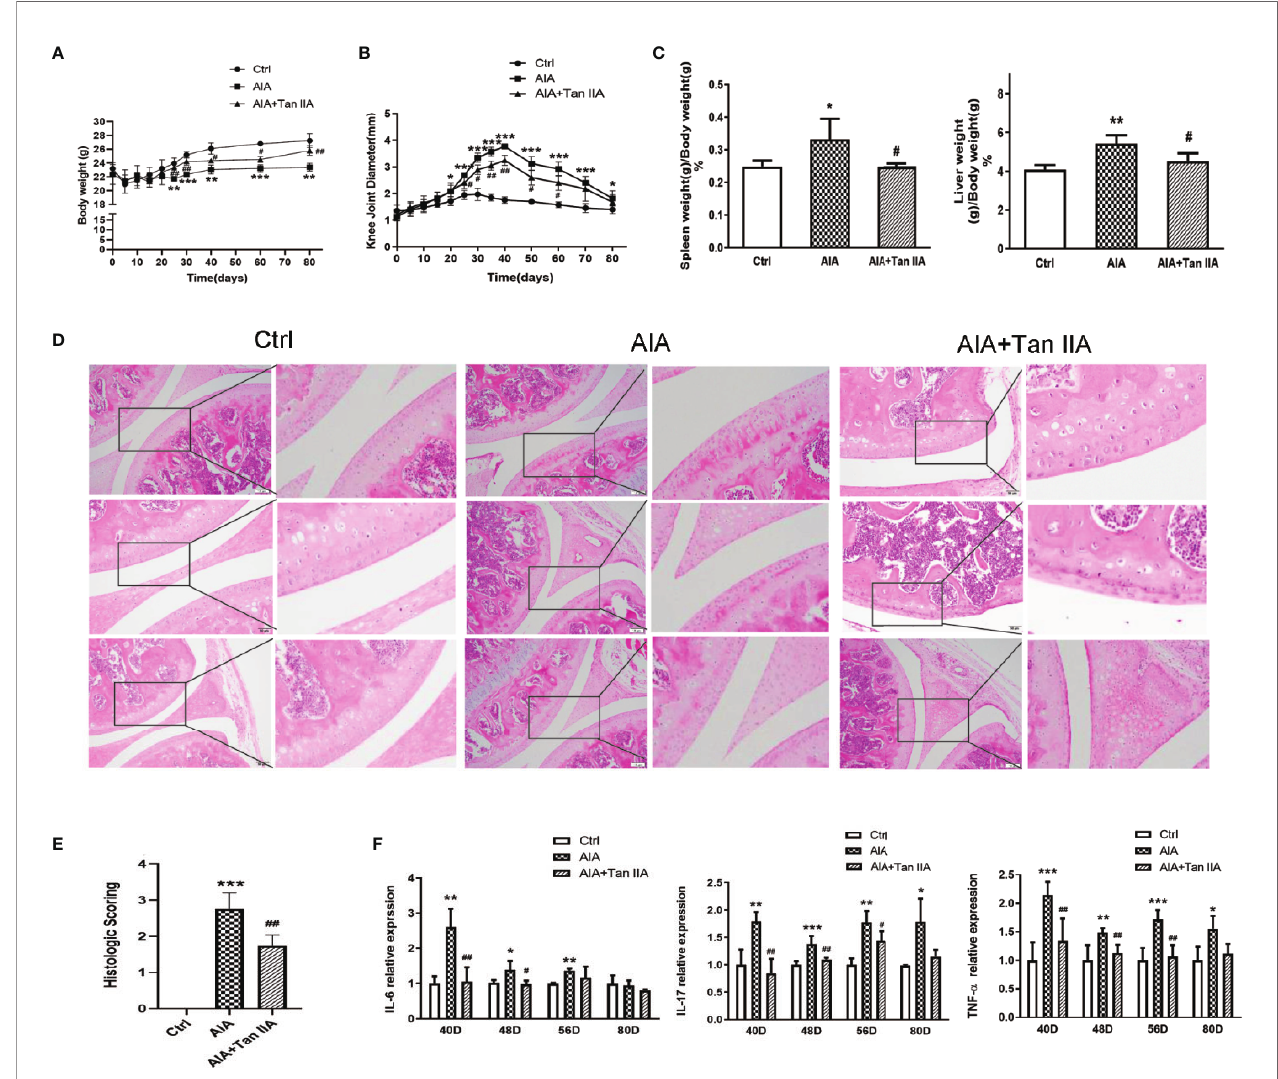
FIGURE 2 | Tan IIA ameliorates arthritis severity in mice with AIA. (A) The effect of Tan IIA on mean change in the body weight of mice after immunization (from day 0 to day 80), monitored every 5 days. (B) The effect of Tan IIA on mean change in knee joint diameter after immunization (from day 0 to day 80), monitored every 5 days. (C) The effect of Tan IIA on the spleen and liver indices of mice with AIA and control. Data are shown as spleen weight (g)/body weight (g) ×100%. (D) The effect of Tan IIA on the pathohistological features of knee joints in mice with AIA. Photomicrographs of knee joint sections stained with H&E (original magni fi cation 200×). (E) The scores for in fl ammatory severity. (F) The effect of Tan IIA on IL-6, IL-17, and TNF- a expression in serum of mice with AIA and control on days 40, 48, 56, and 80 after immunization. All of the data are expressed as means ± S.D. n=6, * P < 0.05, ** P < 0.01, *** P < 0.001 vs. the control group, # P < 0.05, ## P < 0.01, vs. the AIA model